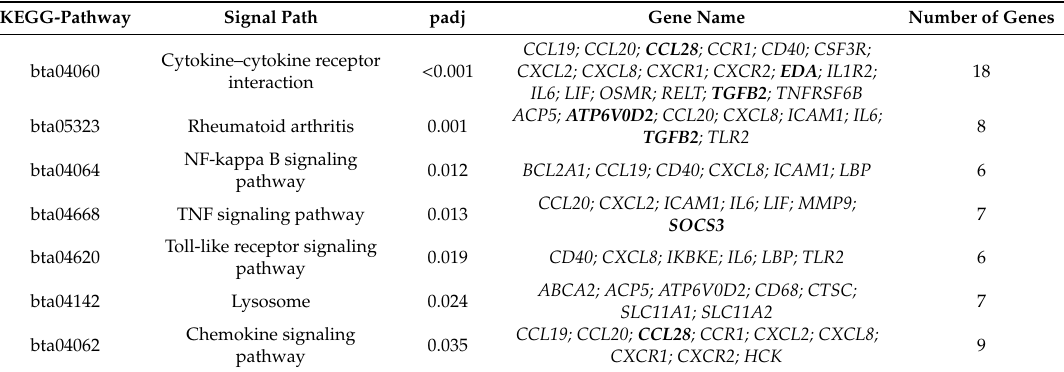
genes were upregulated on the 270th day of lactation. Table 7. Significantly enriched pathways related to inflammation and immunity.